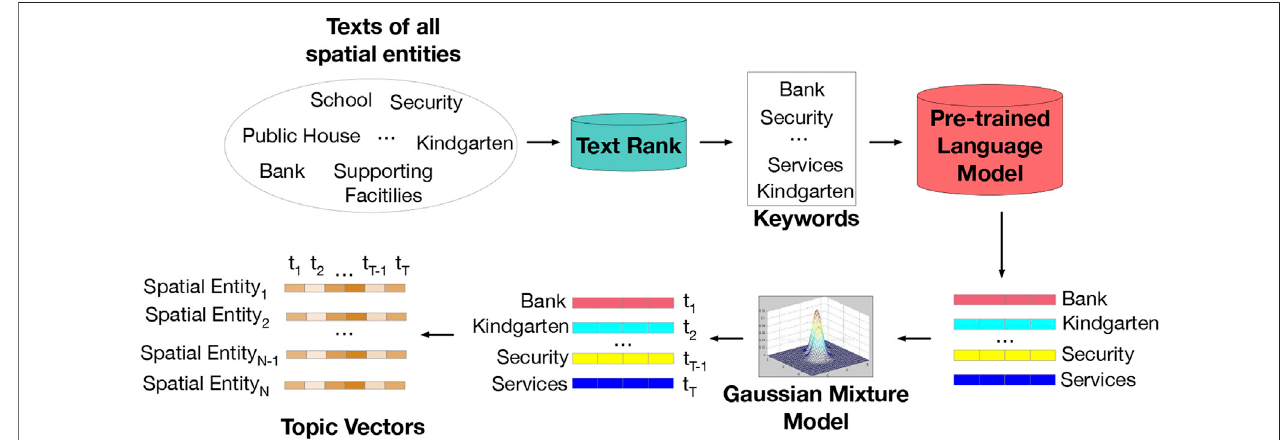
FIGURE 6 | Obtaining the topic vectors of spatial